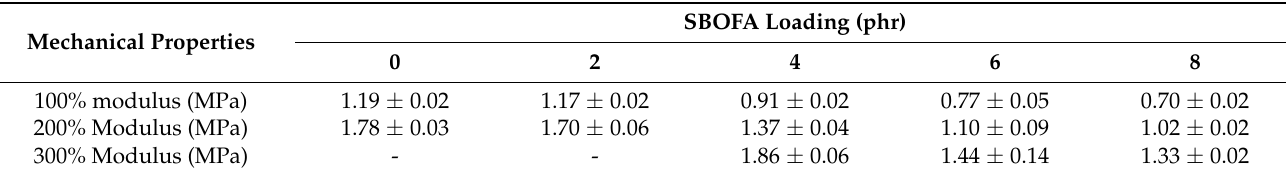
Figure 9. Stress–strain curves of the NBR vulcanizates with varying SBOFA loadings. Table 6. Modulus of the NBR with varying SBOFA loadings.